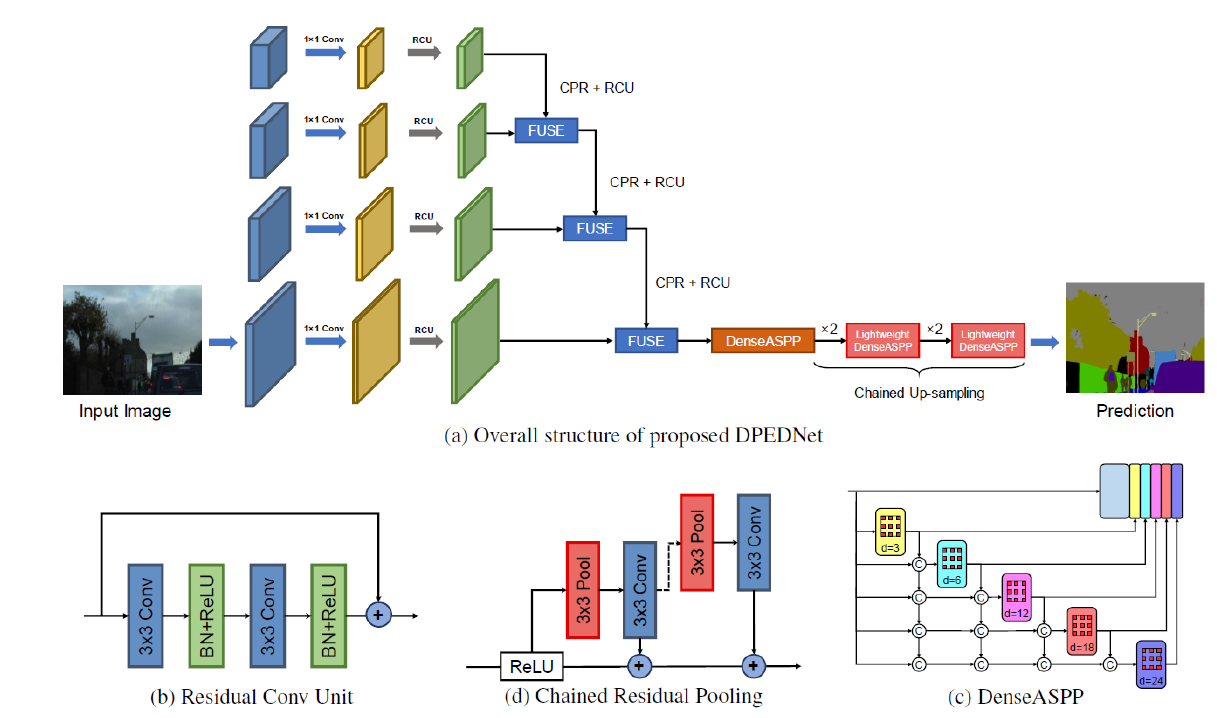
Figure 1. The overall structure of the proposed